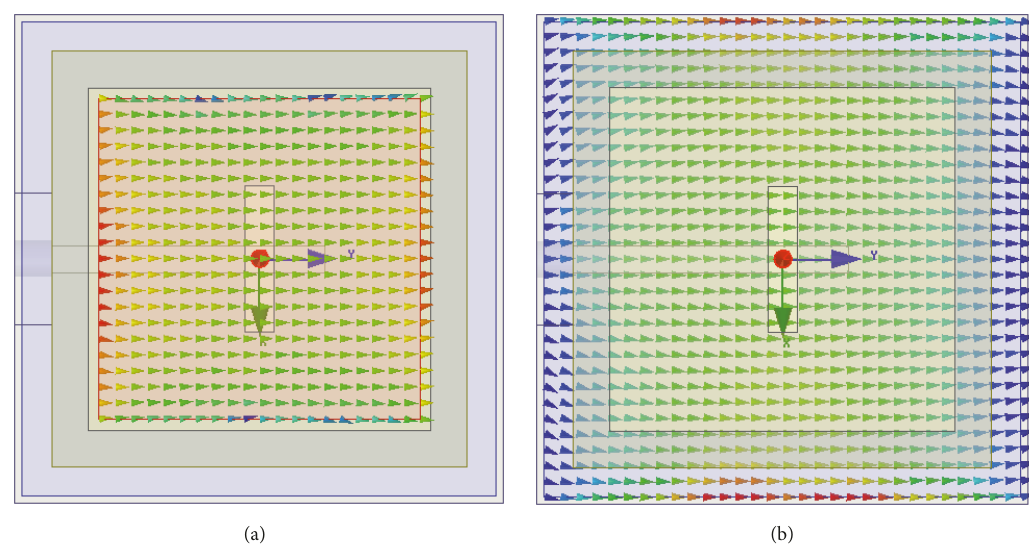
Figure 4: Surface current distributions. (a) Upper patch at 2.1GHz. (b) Lower patch at 1.72 GHz.